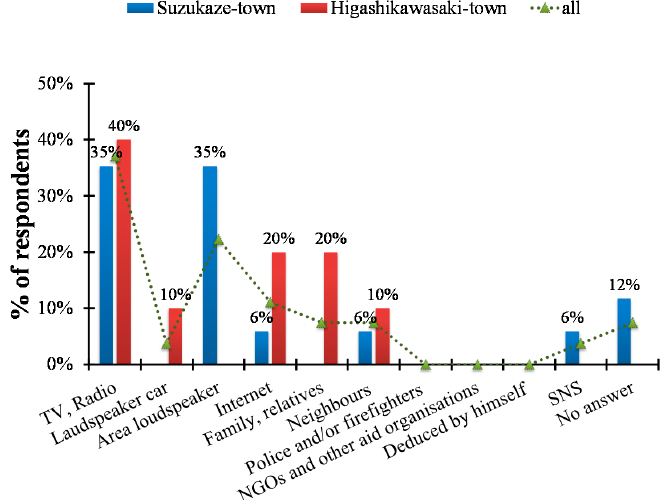
Figure 13. Source of information on storm surge and typhoon (n = 5 for Higashi-Kawasaki town, n = 12 for Suzukaze town, multiple-choice allowed).